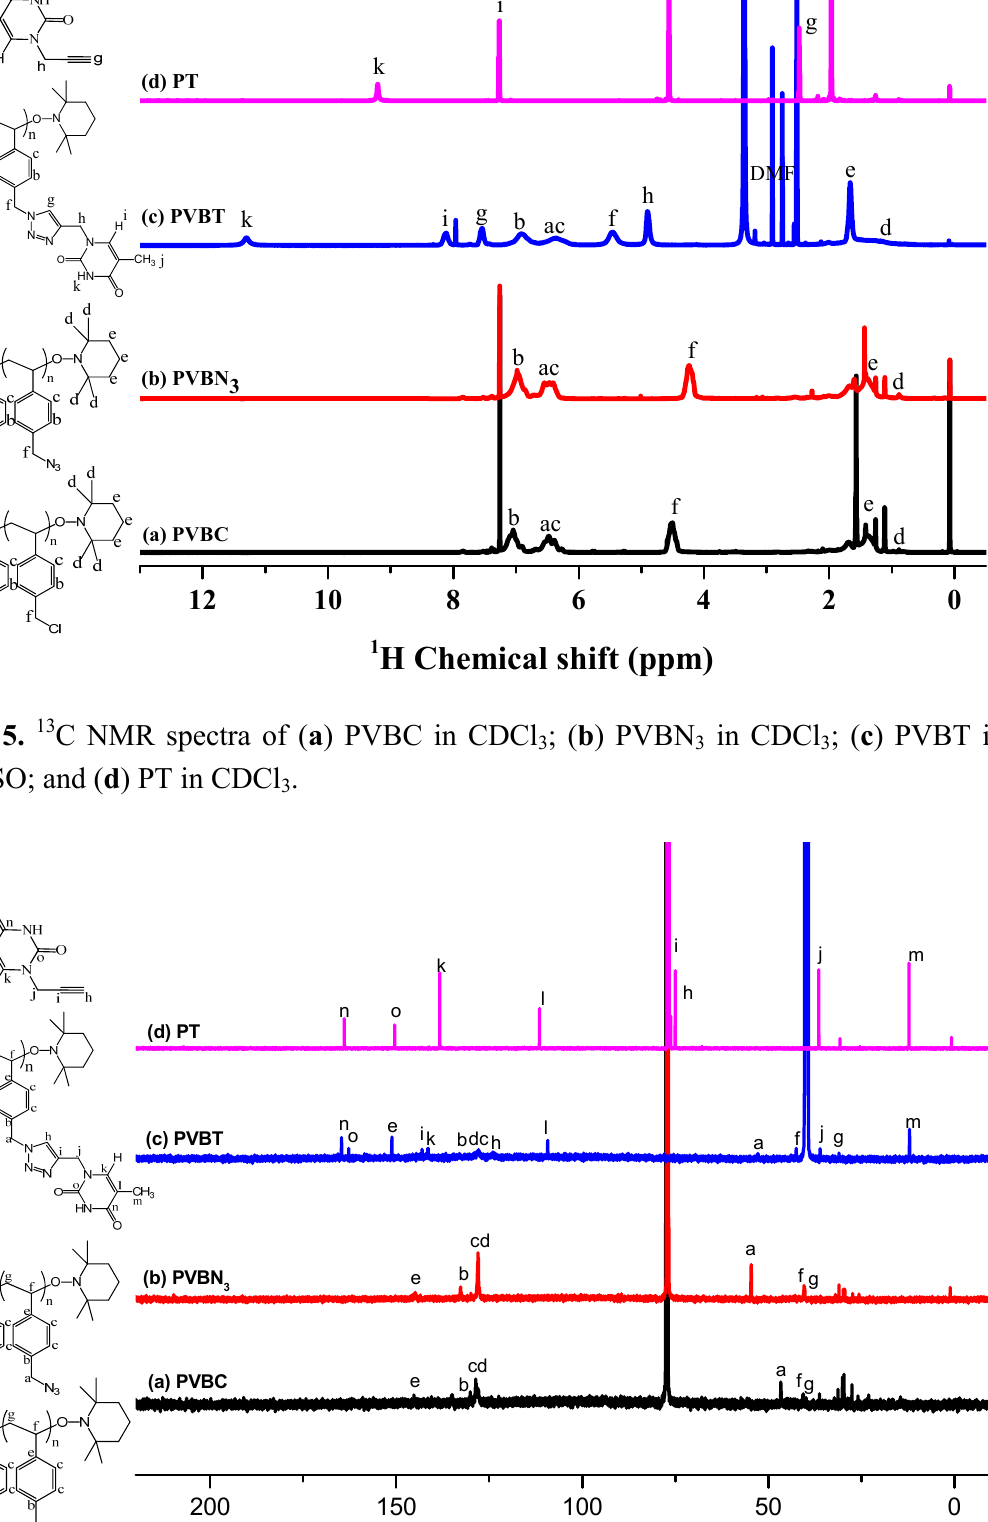
Figure 4. 1 H NMR spectra of ( a ) PVBC in CDCl d -DMSO; and ( d ) PT in CDCl 6